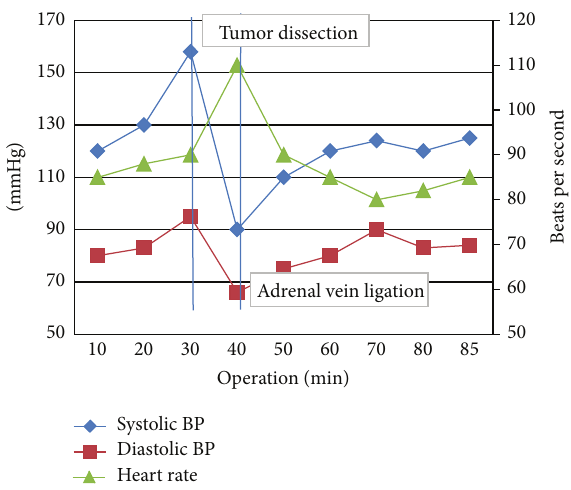
Figure 6: Cardiovascular responses during